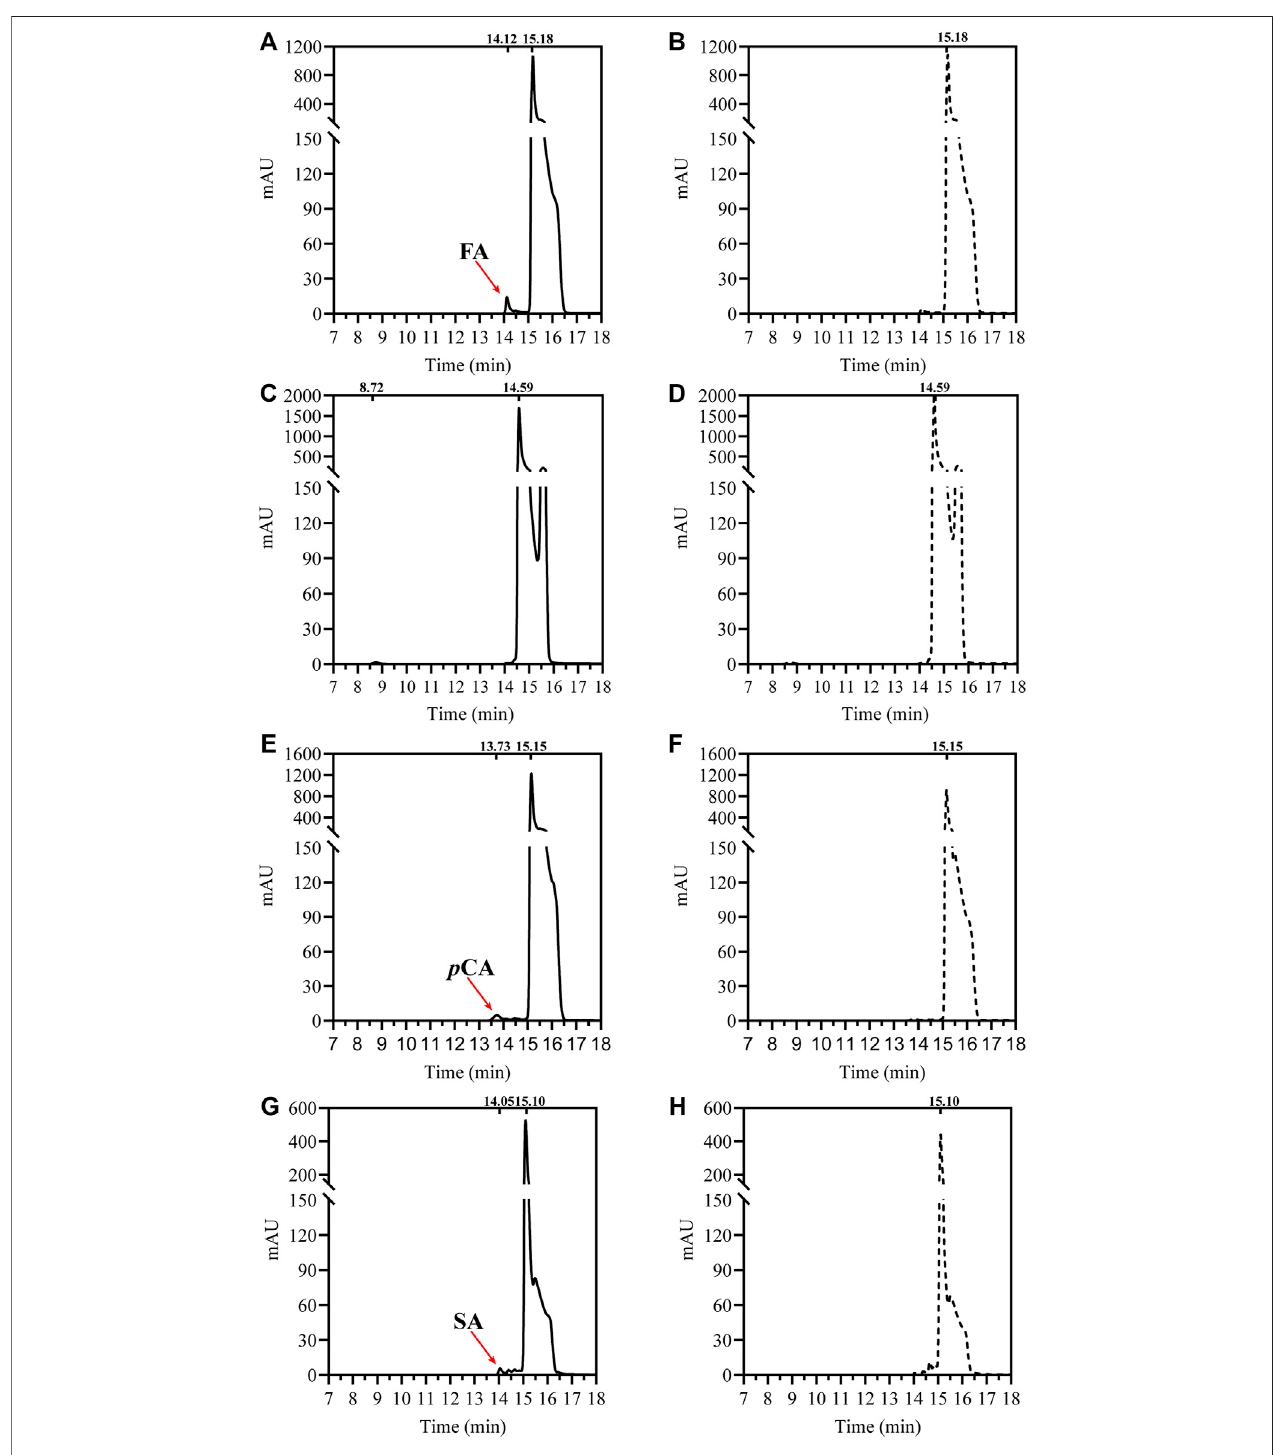
FIGURE 2 | HPLC analysis of Df FAE-catalyzed hydrolysis of four model substrates of FAEs. (A) The product pro fi le of Df FAE-catalyzed hydrolysis of MFA; (B) the blank control group of MFA without adding Df FAE; (C) The product pro fi le of Df FAE-catalyzed hydrolysis of MCA; (D) the blank control group of MCA without adding Df FAE; (E) The product pro fi le of Df FAE-catalyzed hydrolysis of M p CA; (F) the blank control group of M p CA without adding Df FAE; (G) The product pro fi le of Df FAE- catalyzed hydrolysis of MSA; (H) the blank control group of MSA without adding Df FAE. The puri fi ed Df FAE (8 μ M) was incubated with 1.25 mM substrates in 10 mM Tris-HCl buffer (pH 8.4) at 40 ° C for 1 h. The positions of hydroxycinnamic acids and their esters detected in the assays are also indicated. The chromatograms were recorded at 323 nm.